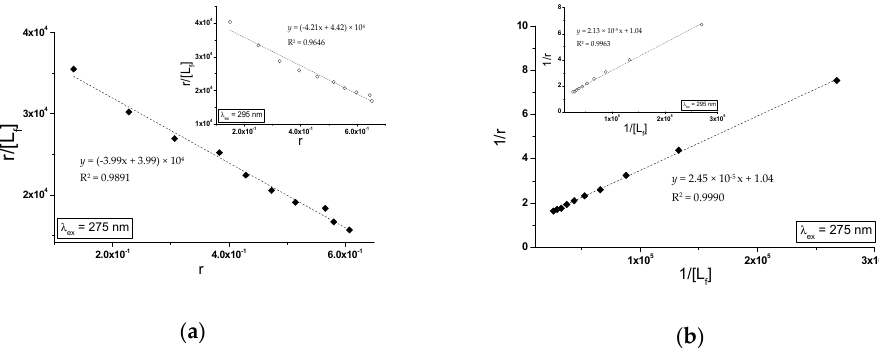
Figure 13. ( a ) The Scatchard curves and ( b ) the Klotz curves for GLZ-(gHSA FRC -PIR) system; λ ex = 275 nm (in the main view) and λ ex = 295 nm (in the insert); the error bars are smaller than the symbols.